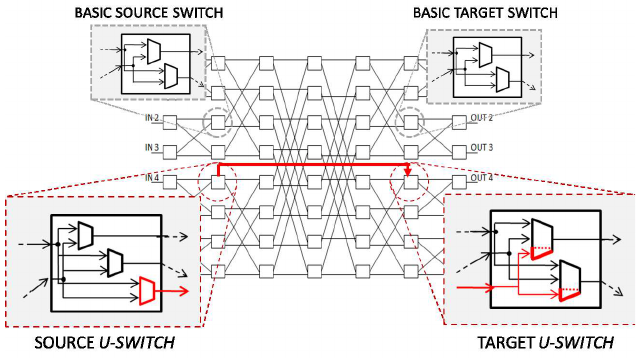
Figure 5. Flat MSSN with bypass enhancement: unfolded view and U-switch structure description